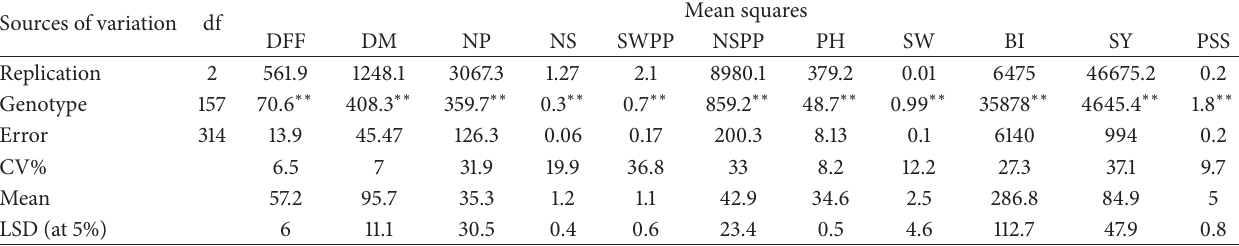
Table 3: Mean squares for agromorphological traits of 158 lentil genotypes at Sirinka in the 2010/11 cropping season. Sources of variation